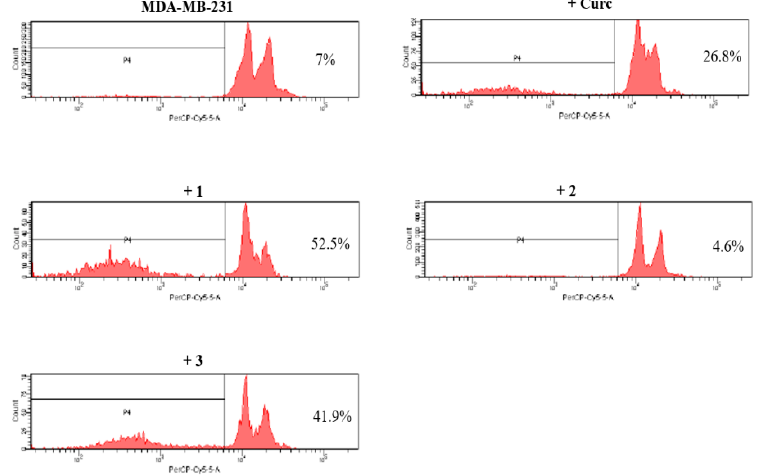
Figure 5. Representative example of flow cytometry analysis with propidium iodide. MDA-MB-231 cells were treated with curcumin and its analogues at 25 µ M for 24 h. Numbers in the panels indicate the % of the events in the preG 0 –G 1 position.